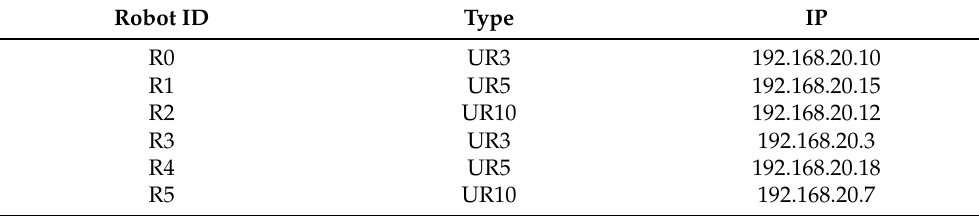
Table 4. This table shows the type and IP of each robot according to the robot